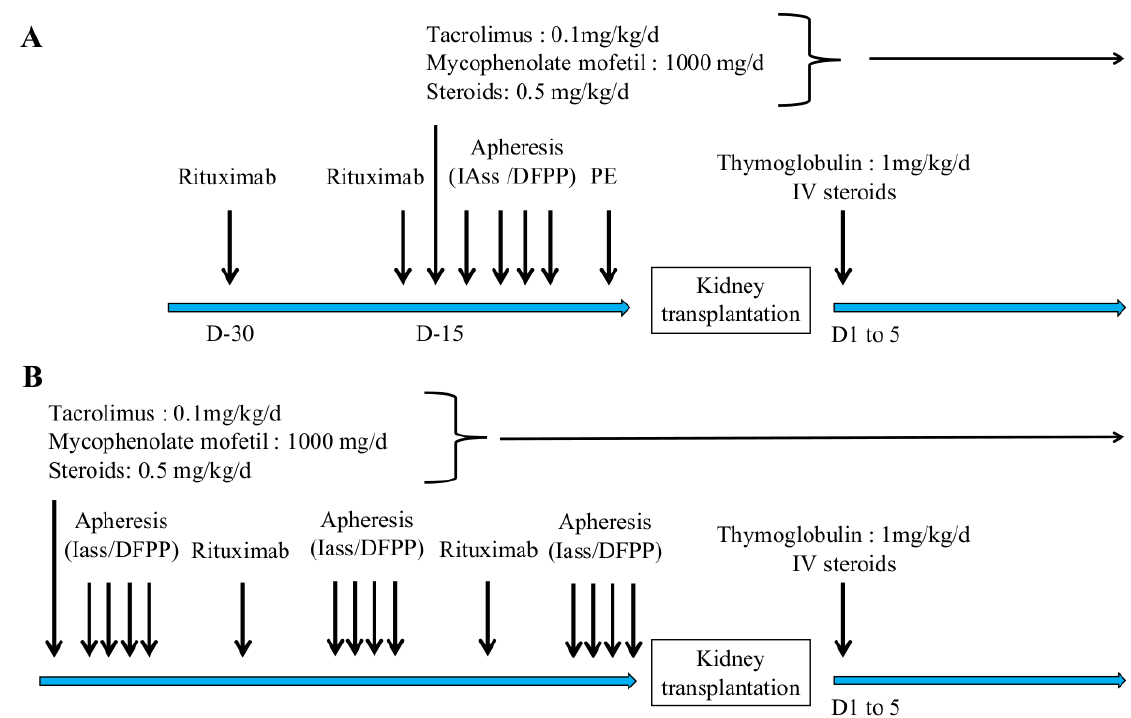
Figure 1. Desensitization and immunosuppression protocol for HLA-incompatible kidney transplantation. Panel ( A ) shows the protocol for living donors HLAi kidney transplantation. Panel ( B ) shows the protocol for deceased donors HLAi kidney transplantation. IAss: semi-specific immunoadsorption; DFPP: double-filtration plasmapheresis; PE: plasma exchange.